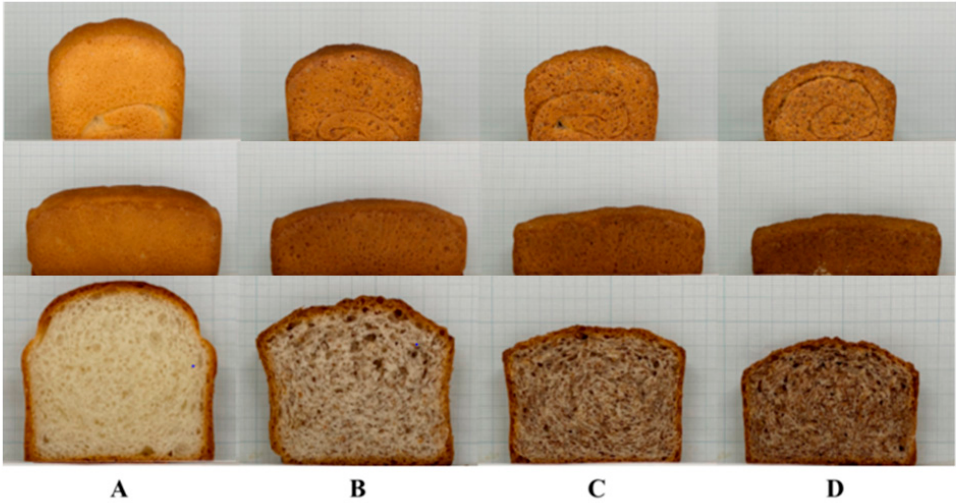
Figure 2. Side view and cross-sections of the breads formulated with the flour–bran blends at dif- different ratios: ( A ) F100/B0; ( B ) F90/B10; ( C ) F80/B20; ( D ) F70/B30. ferent ratios: ( A ) F100/B0; ( B ) F90/B10; ( C ) F80/B20; ( D ) F70/B30.